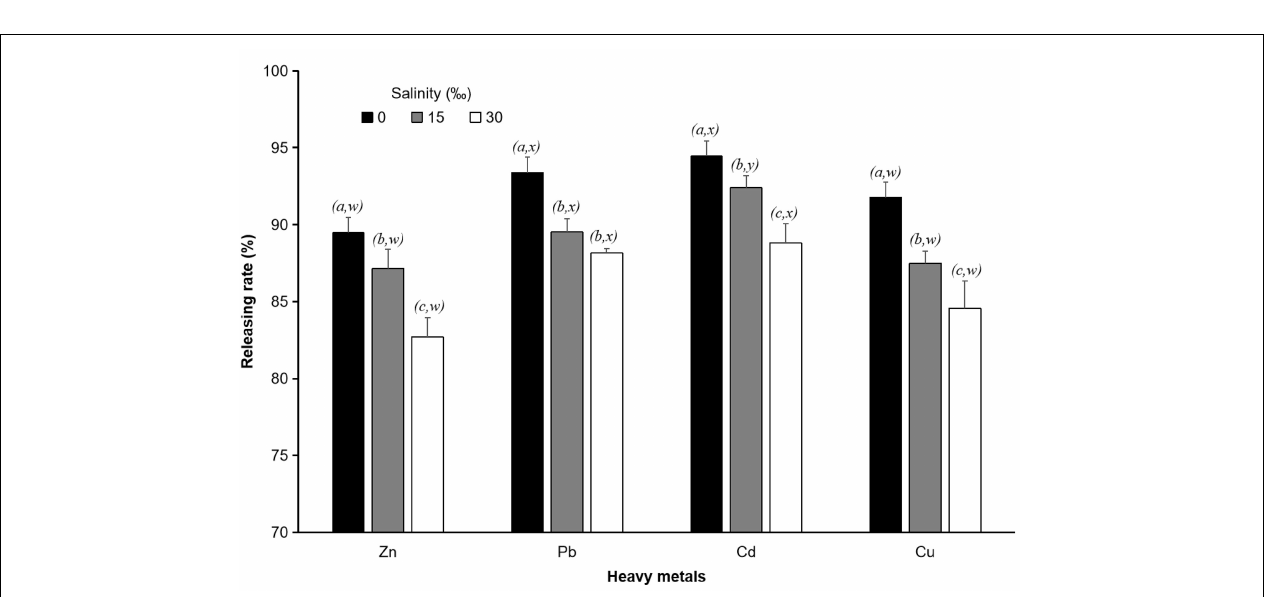
). Data for the release rate (%) of the same heavy metal with (cid:104)